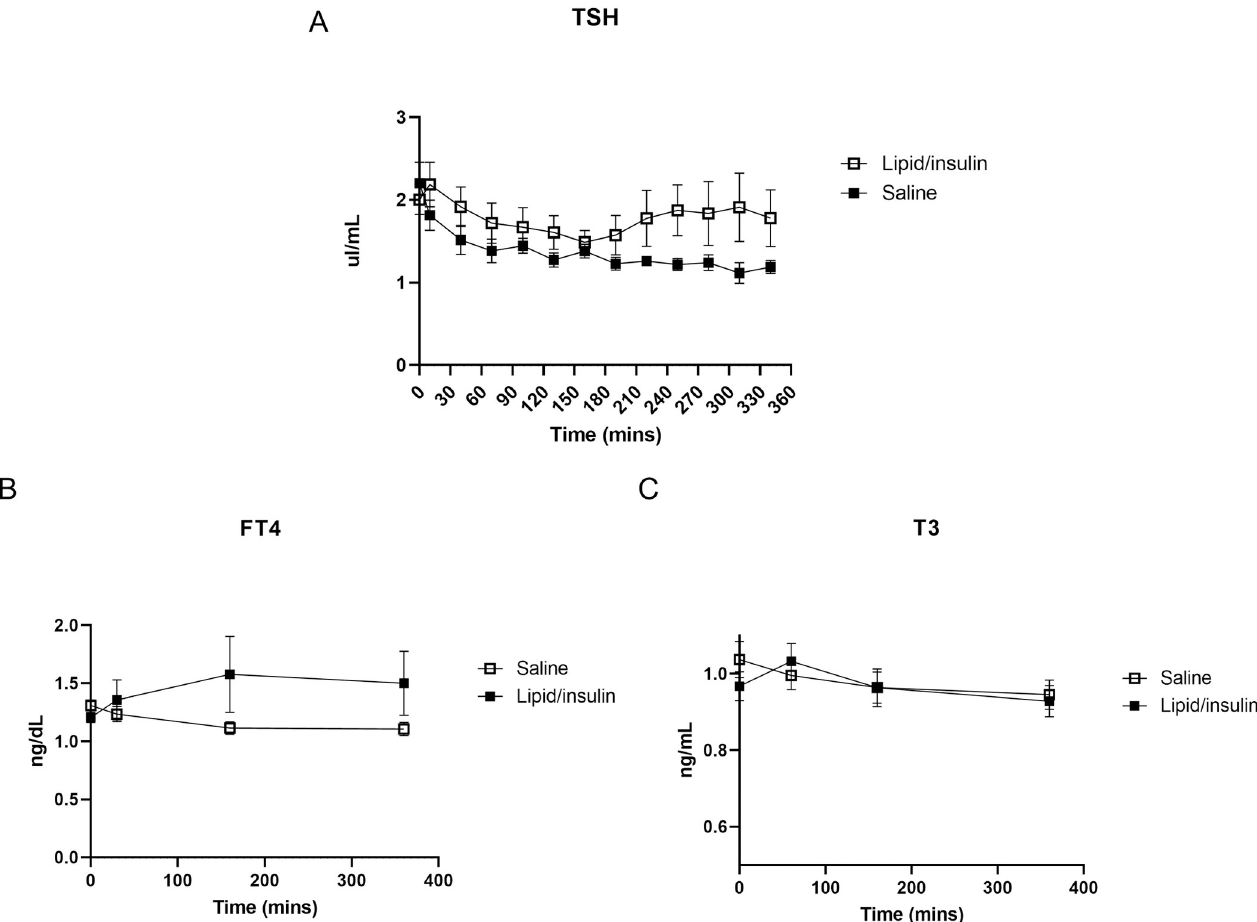
Fig 4. Lipid/insulin infusions may increase relative serum TSH levels but have no effect on thyroid hormones. Hormones were measured as described in methods. (A) Pooled levels of serum TSH were measured every 30 minutes; values are mean ± SEM (n = 11). Pooled levels of (B) serum FT4 and (C) T3 measured at approximately 0, 30, 160, and 360-minutes; values are mean ± SEM (n = 11).